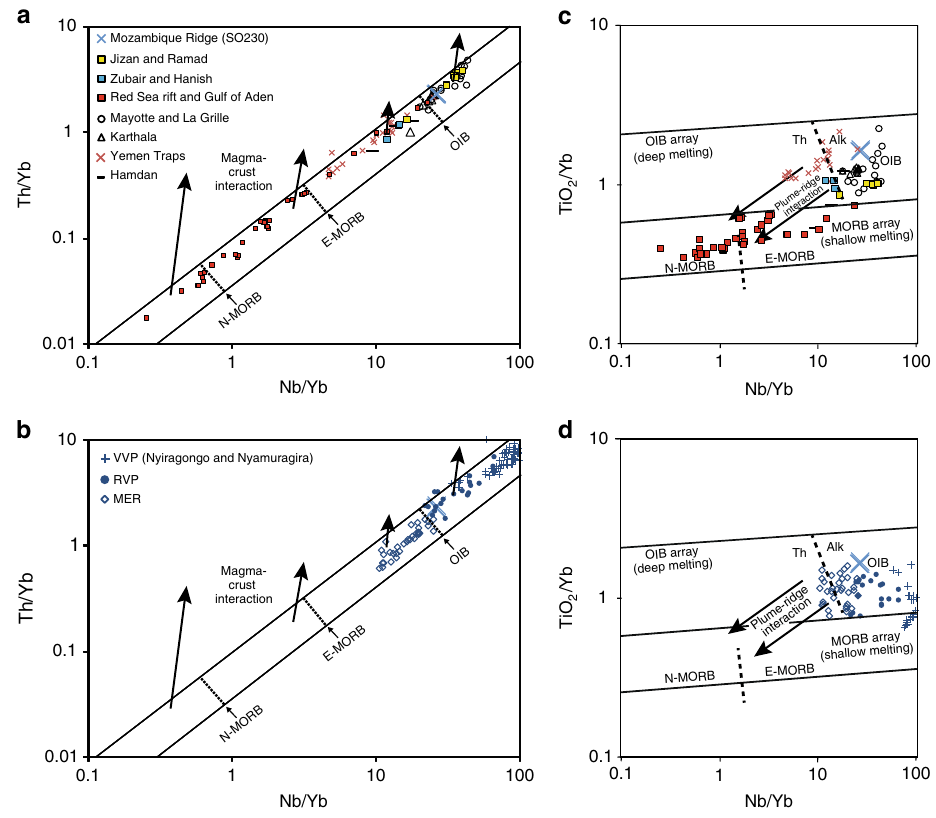
Fig. 4 Trace elemental characteristics. Left panels show the Th – Nb proxy for crustal input 100 . a is for the offshore samples plus the Yemen Traps and Hamdan and b is for the MER, RVP and VVP volcanic provinces. Thorium enrichment is indicative of crustal contamination unrelated to magmatic processes. The Mozambique Ridge OIB samples and other lavas discussed in the text plot within the MORB – OIB array rather than above indicating no signi fi cant Th enrichment. Right panels show the Ti – Yb proxy for depth of melting 100 . c is for the offshore samples plus the Yemen Traps and Hamdan and d is for the MER, RVP and VVP volcanic provinces. Data sources are as follows: Main Ethiopian Rift (MER) 20 , Rungwe Volcanic Province (RVP) 21 , Virungu Volcanic Province (VVP) 21,54 ; Tadjoura Trough, Tadjoura Rift, Asal Rift 52 , Gulf of Aden, Red Sea rift (see compilation of ref. 104 ); Ramad, Jizan, Zubair, Hanish, Hamdan 61 ; Yemen Traps 62 ; La Grille and Karthala (Grande Comore) 67 – 69,105 and Mayotte 66 given lithosphere thickness. The high Th/Nb and Ti/Yb ratios (Fig. 4) show that the Mozambique Ridge lavas erupted on older, thickened lithosphere (high mean pressure and low mean extent of melting) 63 – 66 . Smaller degrees of melting beneath thicker lithosphere will tend to yield melts with higher incompatible trace element concentrations and a lower depleted mantle contribution, which are less susceptible to contamination.